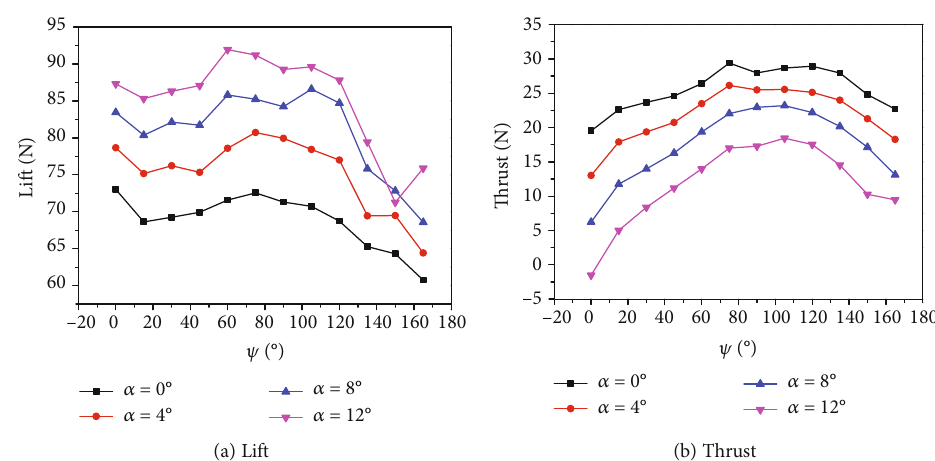
Figure 15: The variation curve of installation angle of a triple leading edge winglet with angle of attack ( v = 12 m/s).